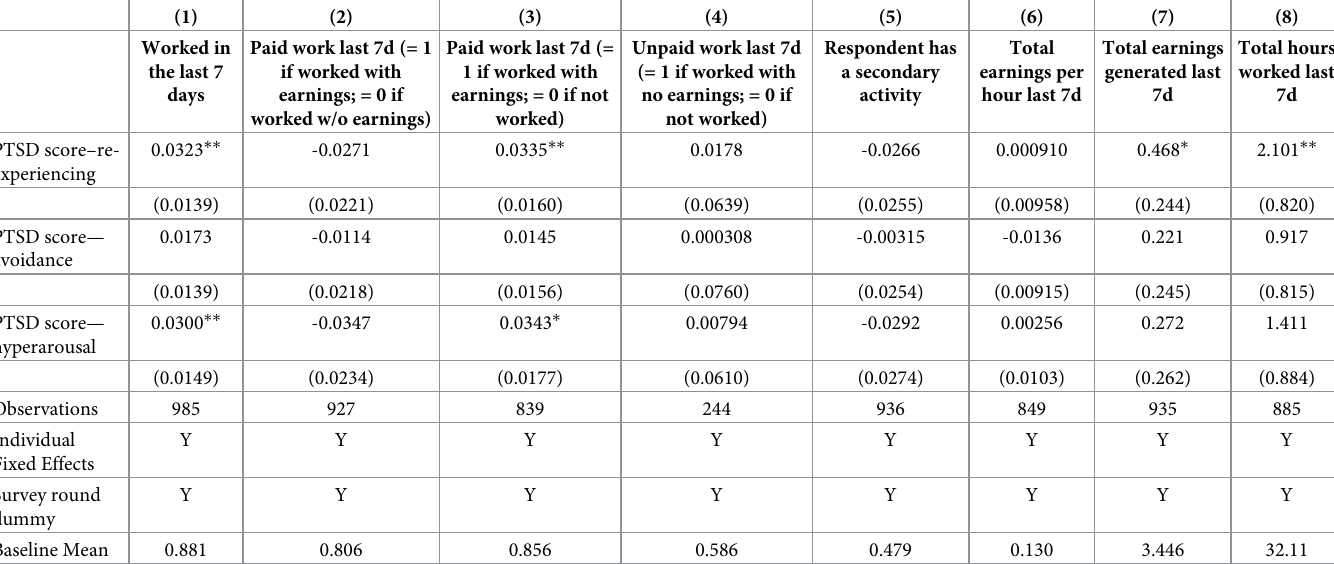
Table 10. Panel regression of women’s work on PTSD symptom clusters, controlling for LFI